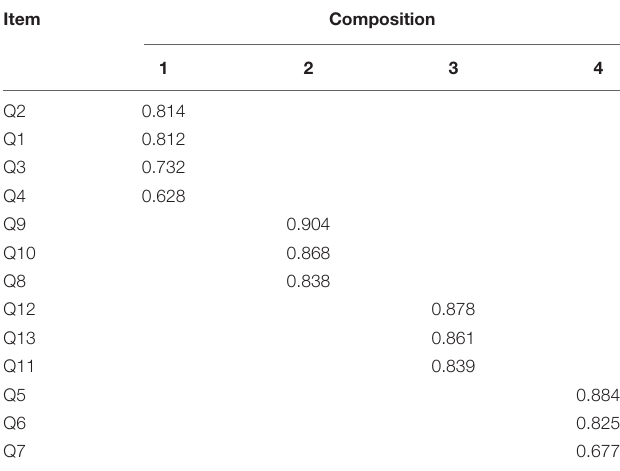
TABLE 1 | Component matrix of learning experience scale after rotation.